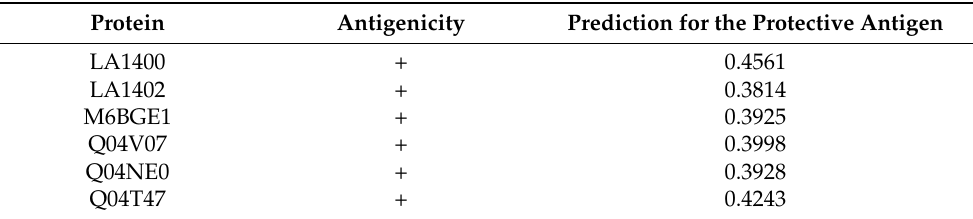
Table 2. Antigenicity prediction using amino acids sequences from L. interrogans Lai and L.